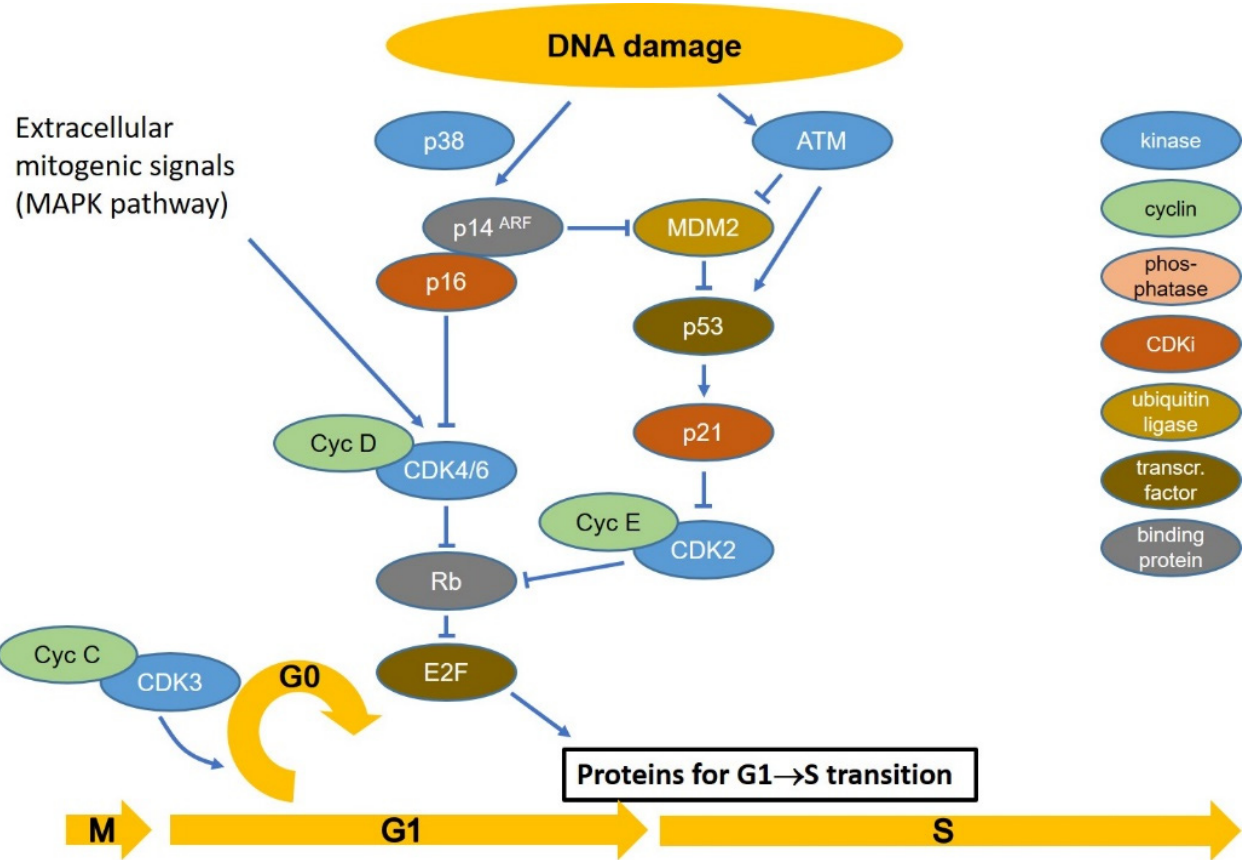
Figure 1. Schematic diagram of the signals regulating the transition of cells from quiescence (G0) to replication in the S-phase and stress-induced arrest at the G1-S transition. Pointed arrows symbolize functional activation, arrows ending with a line symbolize inhibition. In quiescent cells, the RB protein binds to the transcription factor E2F keeping it in an inactive state. Mitogenic signaling causes mono-phosphorylation of RB by the cyclin D-CDK4/6 kinase in early G1 and multiple phosphorylations in late G1, which inactivates RB releasing E2F to transcribe genes for proteins required in S. p53 is continuously expressed but is kept at a low level by binding of the E3 ubiquitin ligase, MDM2, which marks it for proteasomal degradation. The cyclin C-CDK3 complex mediates the transition from G1 to G0 (quiescence). DNA damage disrupts this binding by phosphorylation of MDM2 and p53, increasing p53 levels. P53 transcriptionally activates the CDK inhibitor p21 causing transient cell cycle arrest before the G1-S transition. If the damage is not repairable, the extended G1/S arrest may be reinforced by p16, which inhibits the cyclin D-CDK4/6 complex allowing RB to bind E2F and arrest the cells permanently in G1 (premature differentiation; senescence). The activity of transcription factors and enzymes is regulated by binding proteins and phosphorylation state. Different types of protein are shown in different colors. The active and inactive forms may be either phosphorylated or unphosphorylated, depending on the specific protein. For references, see text. Entry into S-phase from G1 is mediated by the CDK 2/cyclin E complex, which is active when dephosphorylated by CDC25A phosphatase. After initiation of the S-phase, cyclin E is replaced by cyclin A. Normal replication may be halted at stalled replication forks